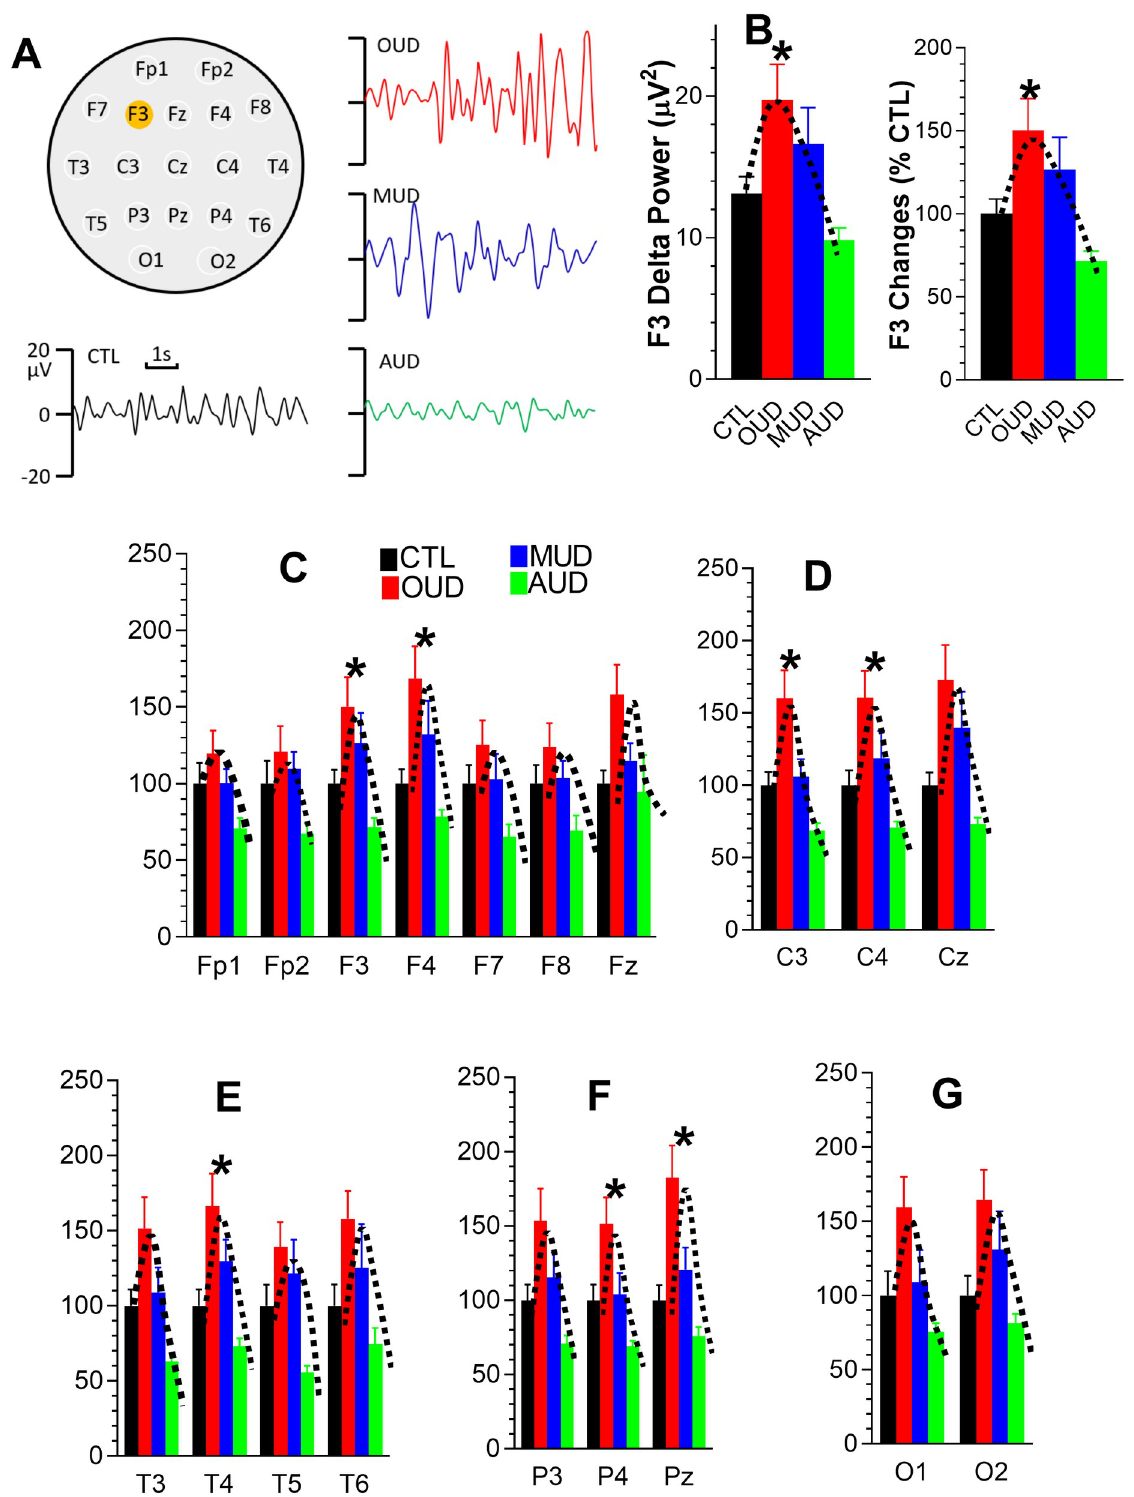
Fig 3. Effects on delta/ δ powers at 19 individual electrodes of patients with OUD, MUD or AUD. A , Representative delta/ δ waves in the F3 electrode from CTL, OUD, MUD and AUD. B , F3 delta/ δ powers expressed as absolute values ( μ V 2 ; left panel) or 100% CTL level (right panel). C , Frontal delta/ δ powers. D , Central delta/ δ powers. E , Temporal delta/ δ powers. F , Parietal delta/ δ powers. G , Occipital delta/ δ powers. � P < 0.05 vs . CTL.